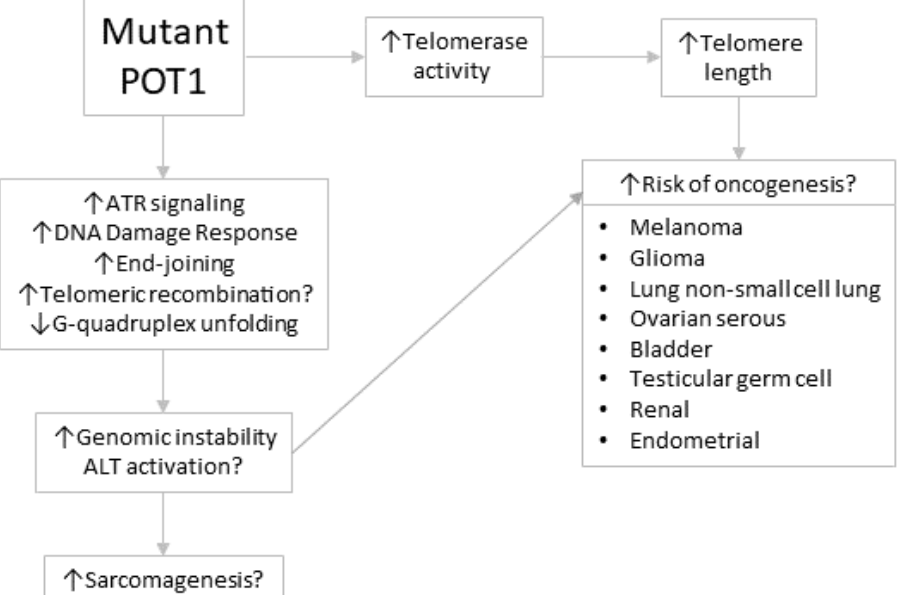
Figure 3. Proposed roles of POT1 mutations in development of cancer. We speculate here that the effects of POT1 mutations differ according to the telomerase status of the cancer progenitor cells, with genomic instability and perhaps the activation of alternative lengthening of telomeres (ALT) being the predominant contributor to oncogenesis in cells that are telomerase-negative and therefore less able to counteract the deleterious effects of the POT1 mutation on telomere cap function, and with increased telomere length being the predominant contributor when the progenitor cells have telomerase activity.